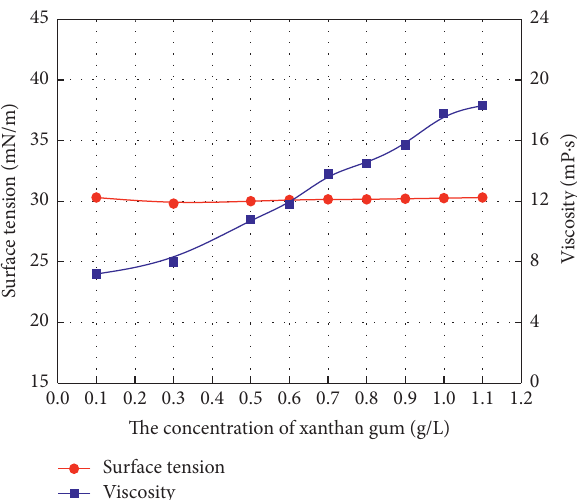
Figure 7: The curve of surface tension and viscosity under different concentrations of xanthan gum.